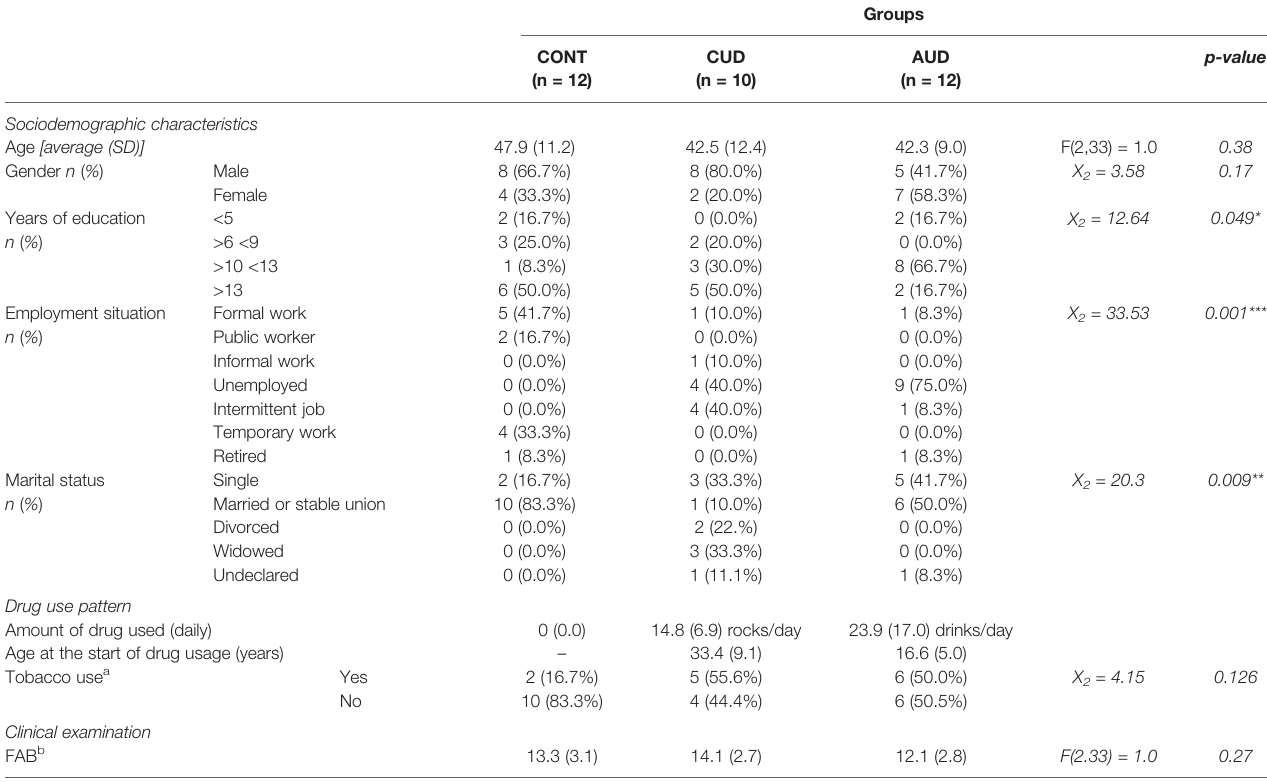
TABLE 1 | Socio-demographic characteristics of the healthy non-addicted controls (CONT, n = 12), crack-cocaine use disorder (CUD, n = 10) and alcohol use disorder (AUD, n = 12) patients.